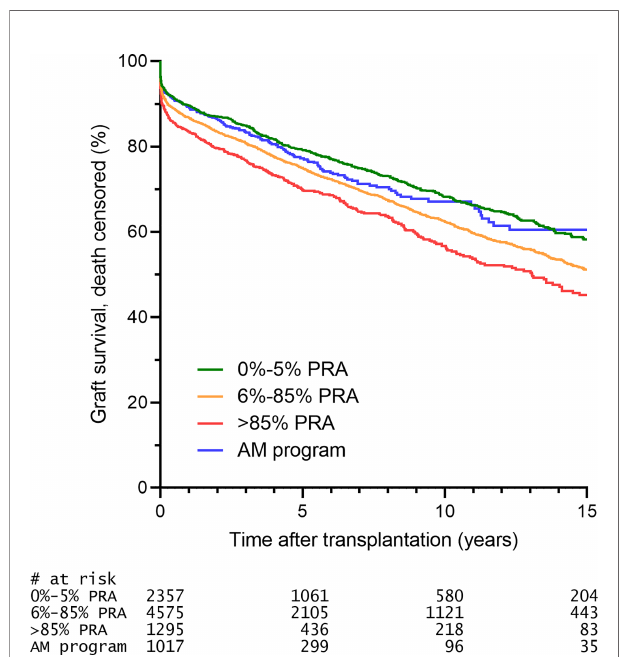
FIGURE 3 | The 15-year death censored graft survival of AM patients is similar to that of unsensitized patients. Selection was based on criteria described prior (16) and included: transplantation from 1996 onwards (start ETKAS allocation), minimum 1 HLA mismatch, kidney only, repeat transplants (since the vast majority of AM patients are repeat transplant candidates). Patients transplanted through ETKAS are subdivided into 0-5% PRA (non- sensitized), 6-85% PRA (intermediately sensitized), >85% PRA (highly sensitized, transplanted outside the AM